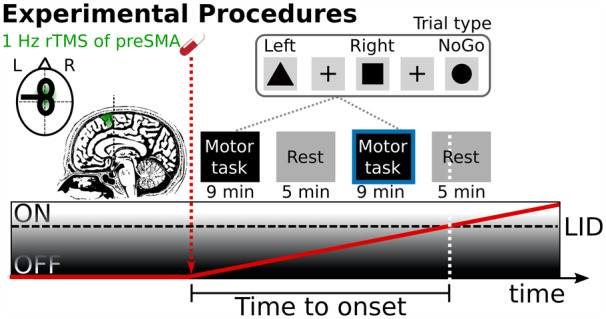

Experimental procedures and timeline. Patients underwent robot-guided real or sham 1-Hz rTMS of preSMA in counterbalanced order on two separate days. The preSMA was targeted with stereotactic neuronavigation using the peak activation from a previous fMRI study (Herz et al., 2014) as target site [Montreal Neurological Institute (MNI) coordinates: x, y, z = 4, 8, 58 mm]. Patients were OFF their usual dopamine replacement therapy. After 1-Hz rTMS of preSMA, patients received an oral solution of 200 mg levodopa and underwent task-based and resting-state fMRI runs in alternating order until patients developed peak-of-dose LID. During task-based fMRI, patients performed a stimulus-response mapping task. The fMRI analysis focussed on the last completed run before the emergence of LID (blue border).